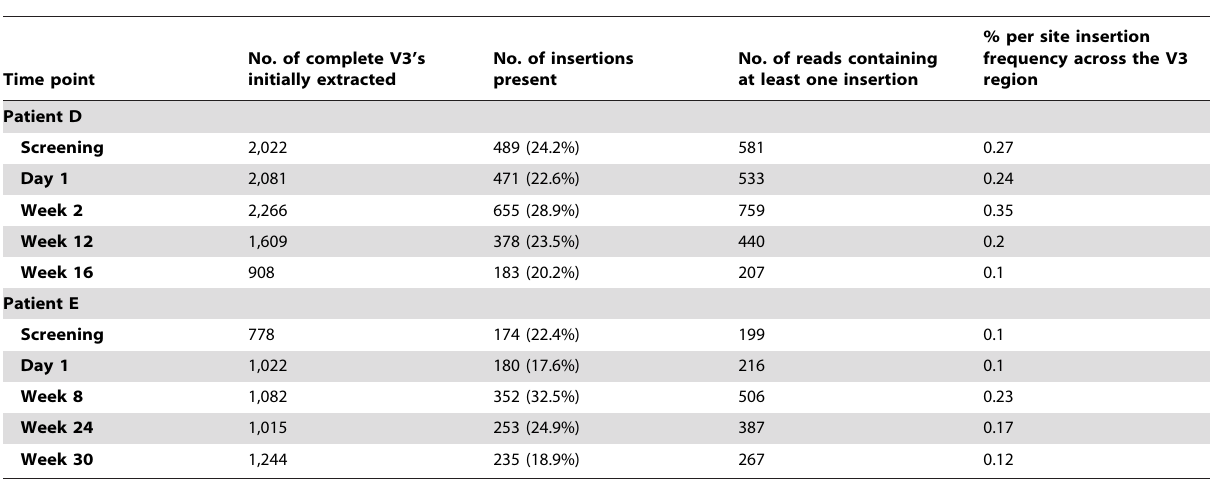
Table 2. V3 region coverage.